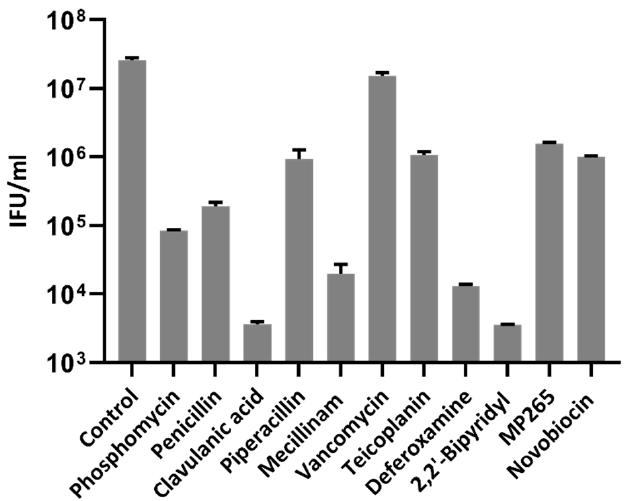
Figure 4. Stress stimuli decrease production of infectious elementary bodies (EBs). Waddlia -infected Vero cells were treated at 2 hpi with drug concentrations listed in Table 1. Infected cell lysates were collected at 48 hpi and used for infectious titers analysis. Results are presented as IFU per milliliter of inoculum. The limit of detection corresponds to one inclusion for 500 Vero cells, which represents a calculated value of approximately 10 3 IFU/mL. Error bars represent the SD of duplicates from one